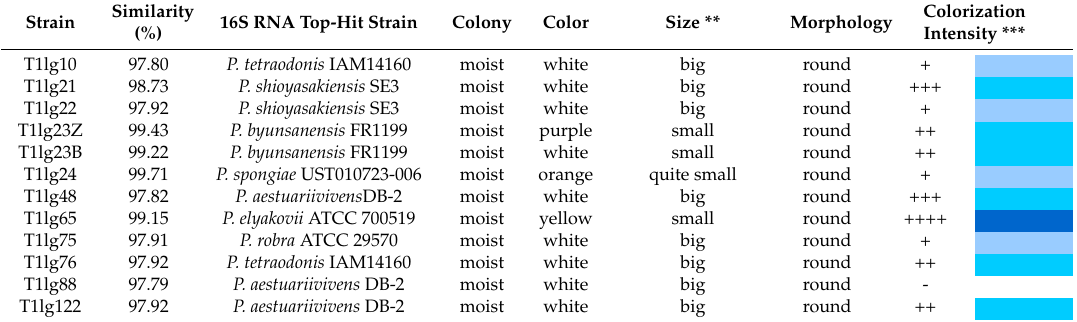
Table 1. Colony morphology and cross-feeding bioassay for AHL-based quorum sensing phenomenon of Pseudoalteromonas